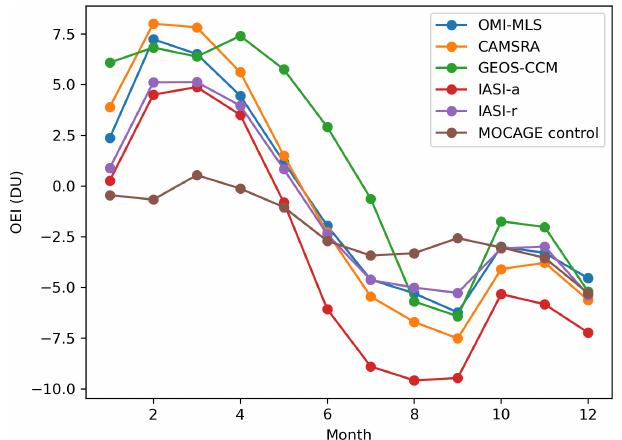
Figure 8. Ozone ENSO index (OEI) from OMI-MLS measurements (blue line), CAMSRA reanalysis (orange), GEOS-CCM simulation (green), IASI-a reanalysis (red), IASI-r reanalysis (violet), and the MOCAGE control simulation